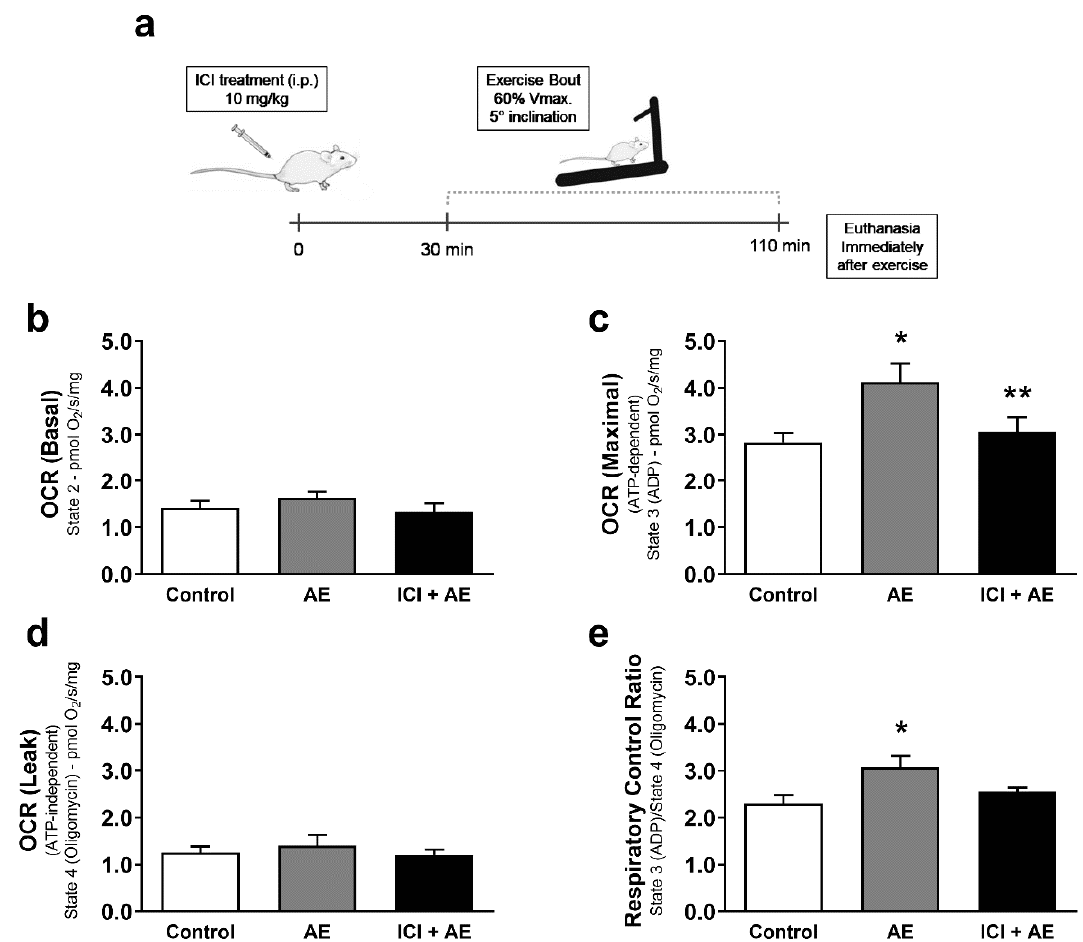
Figure 1. Exercise-induced maximal mitochondrial respiration is dependent on β 2 -adrenergic receptor ( β 2 -AR) signaling. Experimental design for aerobic exercise under β 2 -AR blockade with ICI 118,551 ( a ), basal mitochondrial OCR (oxygen consumption ratio) ( b ), maximal mitochondrial OCR induced by ADP ( c ), ATP-independent OCR measured in the presence of oligomycin ( d ), and the respiratory control ratio ( e ) in permeabilized fiber bundles of tibialis anterior muscle isolated from exercised mice (single bout in a treadmill—80% of Vmax for 1 h, 5° inclination), and/or under β 2 -AR receptor blockade with ICI 118,551 (single dose—10 mg/kg, i.p., 30 min prior to exercise). Data are presented as mean ± SE. * p < 0.05 vs. control and ** p < 0.05 vs. AE. n = 5/group.